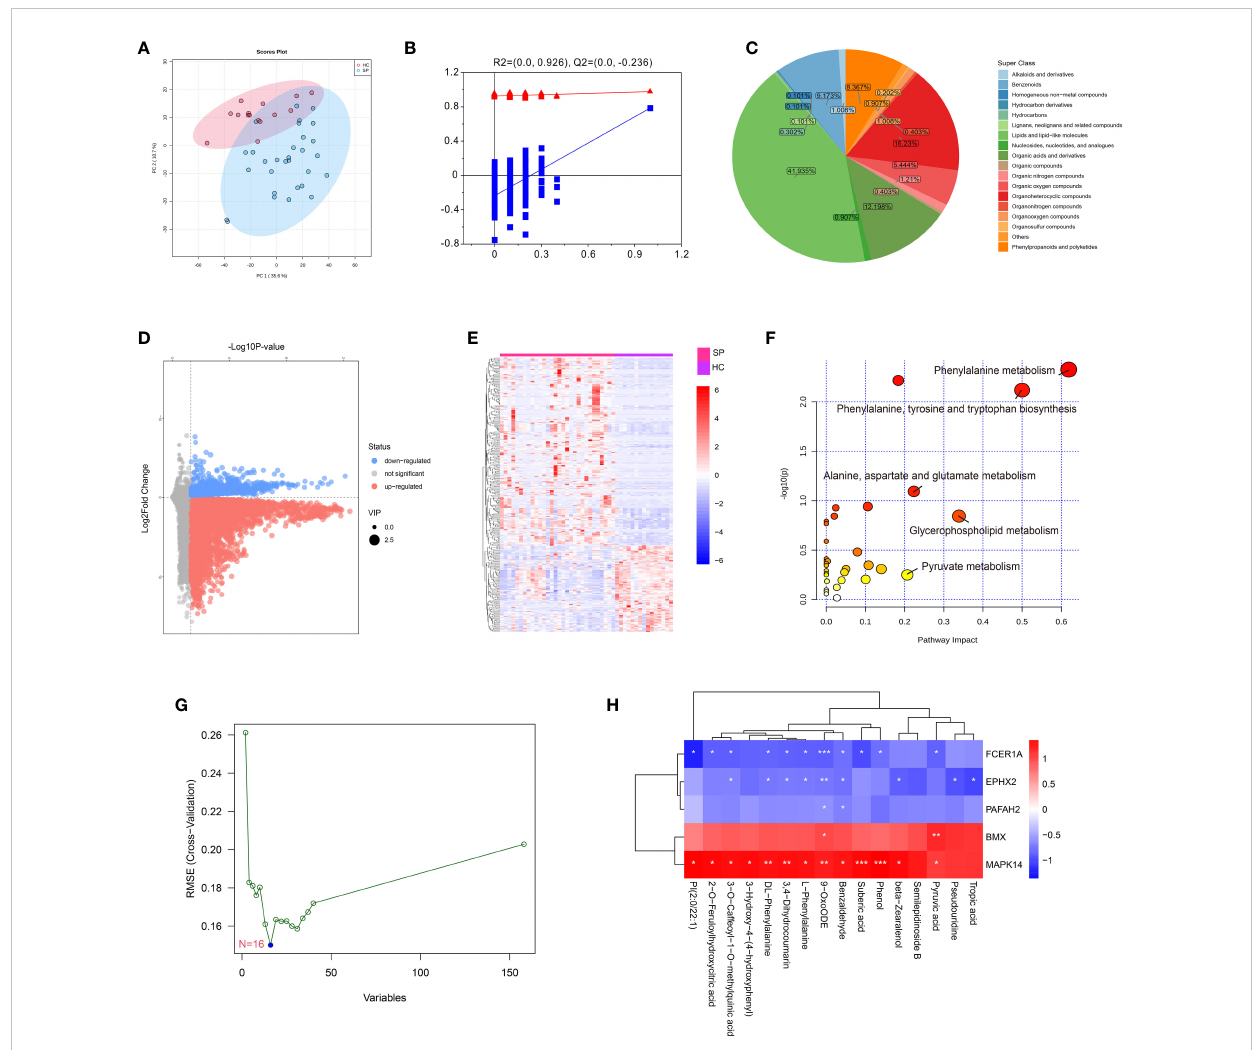
FIGURE 7 Metabolomics pro fi ling of healthy control and sepsis patients. (A) Principal component analysis (PCA) scores plot for metabolomics analysis in sepsis and control. (B) OPLSDA plot. The ordinate represents the value of R 2 Y or Q 2 , the abscissa represents the degree of substitution retention, the red dot represents the R 2 Y value of the substitution test, the blue dot represents the Q 2 value of the substitution test, and the two dashed lines represent the regression lines of R 2 Y and Q 2 , respectively. (C) Pie chart analysis of differentially-expressed metabolites categories. Each color represents a different category of substances. (D) Volcano plot, and (E) Heat map analyzed by TBtools showing the signi fi cantly changed metabolites in sepsis and control. (F) Bubble plot of enriched pathways of differentially-expressed metabolites. Each bubble represents a metabolic pathway, with the position and size of the bubble indicating the impact of the pathway in the topological analysis. The color of the bubble indicates the P-value, with redder colors indicating smaller P-value and more signi fi cant enrichment. (G) Support vector machine (SVM) for hub metabolites, the optimal variables were screened out based on the “ e1071 ” package. (H) Person ’ s correlation analysis between hub metabolisms and identi fi ed hub genes. *: as compared with the Control group, P < 0.05; **: as compared with the Control group, P < 0.01; ***: as compared with the Control group, P